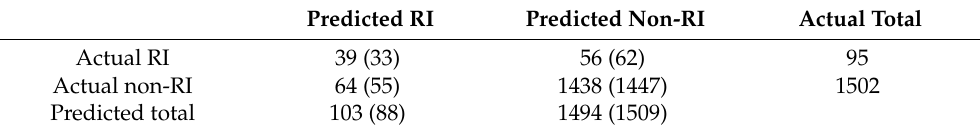
Table 8. Confusion matrix values after [MA] (before [MB]) hyperparameter tuning with the test data. Predicted RI Predicted Non-RI Actual Total Actual RI 39 (33) 56 (62) 95 Actual non-RI 64 (55) 1438 (1447) 1502 Predicted total 103 (88) 1494 (1509)